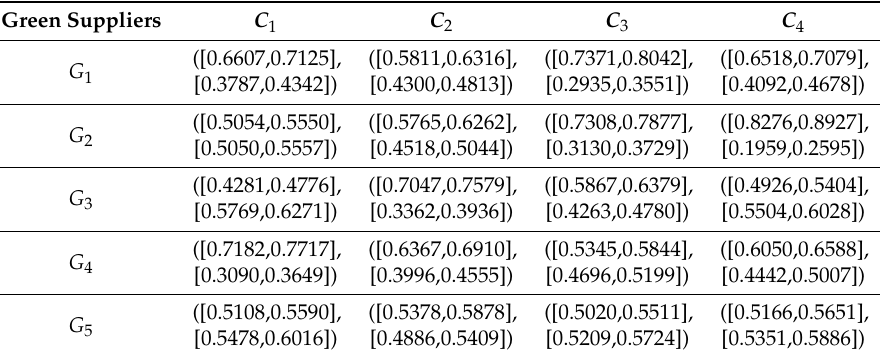
Table 6. Collective evaluation matrix.